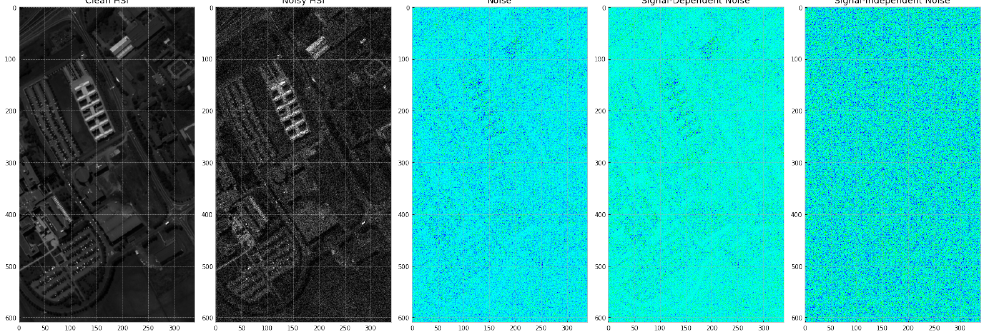
Figure 7. 30th band of Pavia University HSI. SNR = − 15, α = 5.